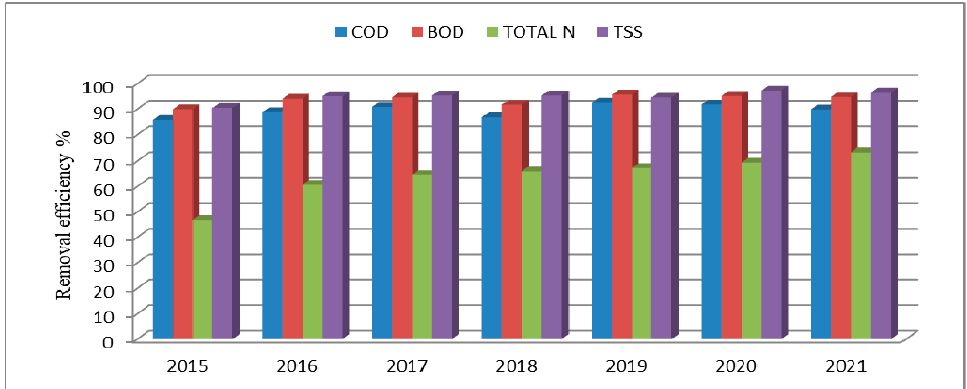
Figure 3. Removal efficiency for the main pollutants during the period 2015–2021.